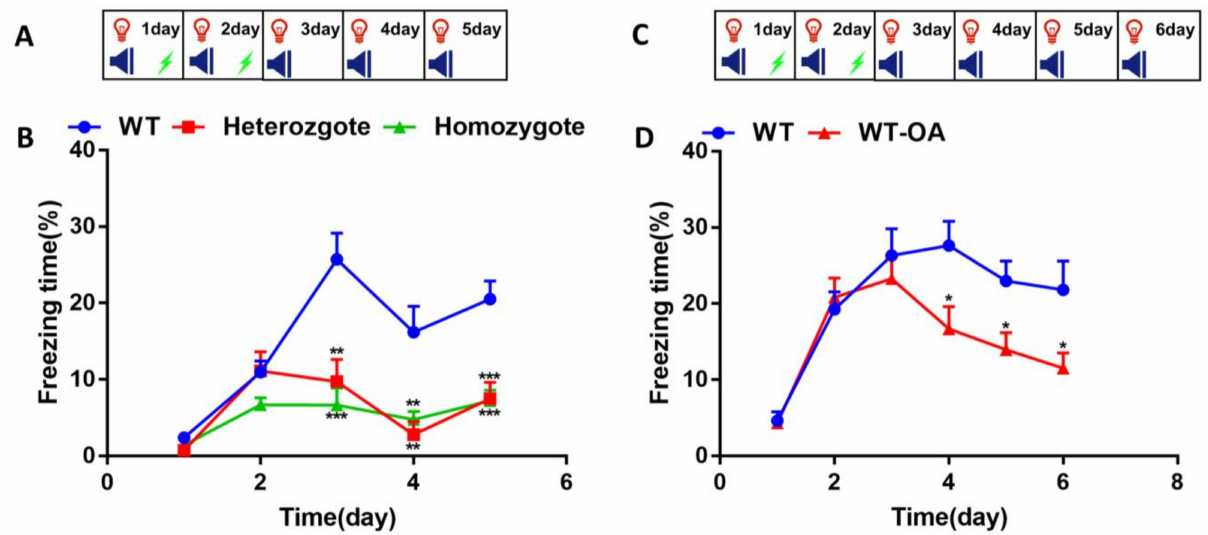
Figure 4. Inhibition of BChE accelerated fear extinction memory in 6 and 8-month-old mice. On days 1–2, the freezing time was measured during 180 s of adaptation and 2 cycles of CS+US; on the other days, the freezing time was measured during 180s of adaptation and 2 cycles of CS. ( A ) Experimental design for the fear extinction training in 6-month-old BChE KO mice. ( B ) The percentage of freezing time in BChE KO mice. ( C ) Experimental design for the fear conditioning memory in ( R )-bambuterol treated 8-month-old mice. ( D ) The percentage of freezing time in mice with oral administration of (R)-bambuterol (WT-OA). n = 7–8 mice per group. Data were shown as mean ± SEM. * p < 0.05; ** p < 0.01; *** p < 0.001; versus WT group, one-way ANOVA followed by Tukey’s post hoc test (for B ) and unpaired t-test (for D